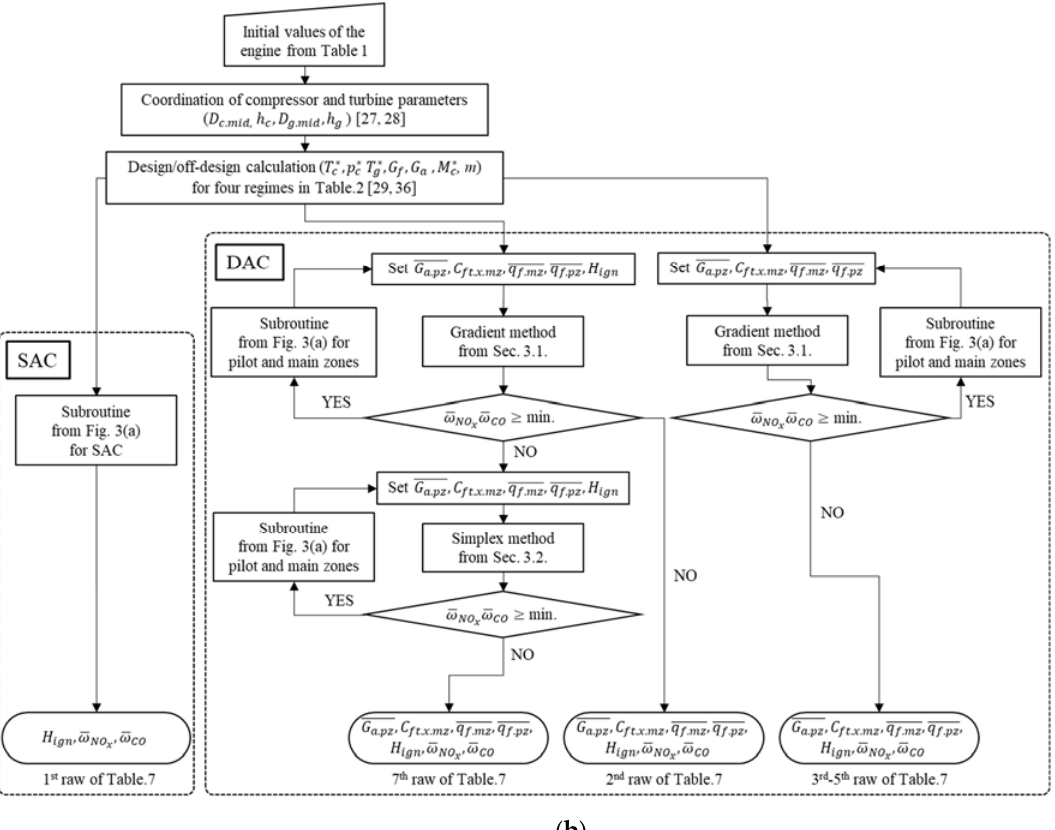
Figure 5. Block diagram of calculation [32]. ( a ) Subroutine flowchart of calculation procedure for combustor designing. ( b ) Flowchart for the optimization plan [27–29,36].